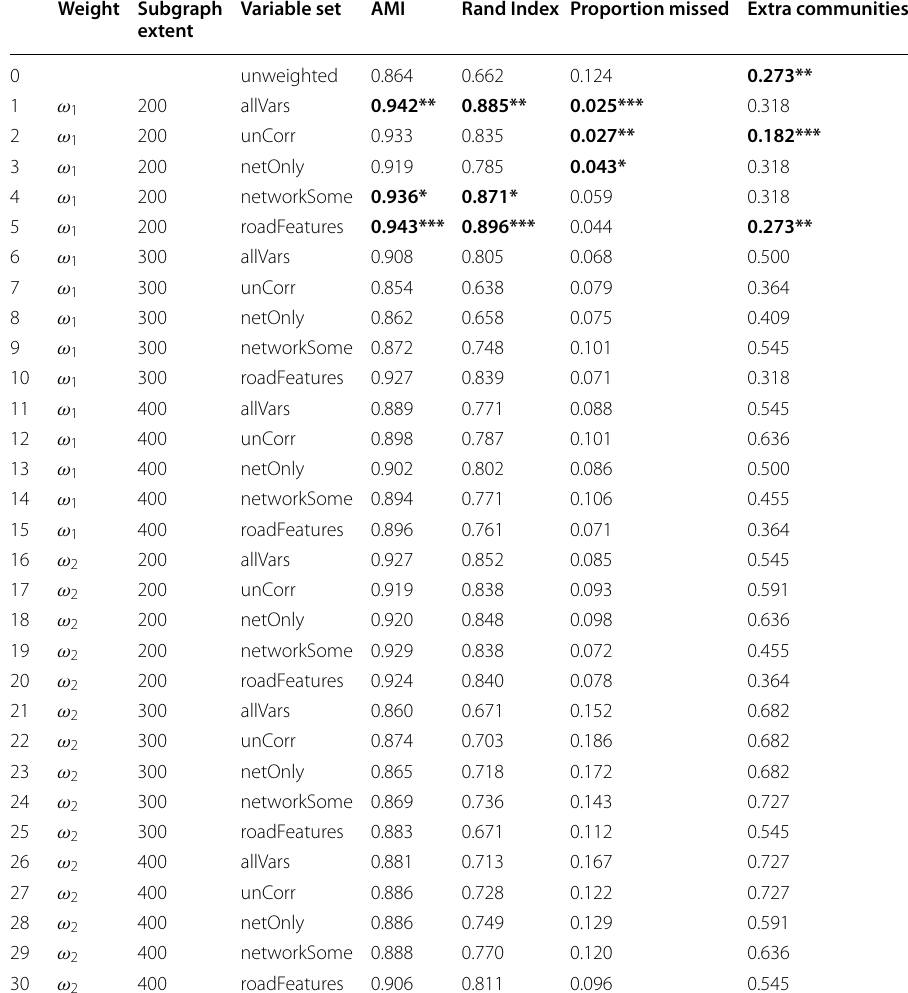
Table 3 Community detection accuracy results for each parameter combination